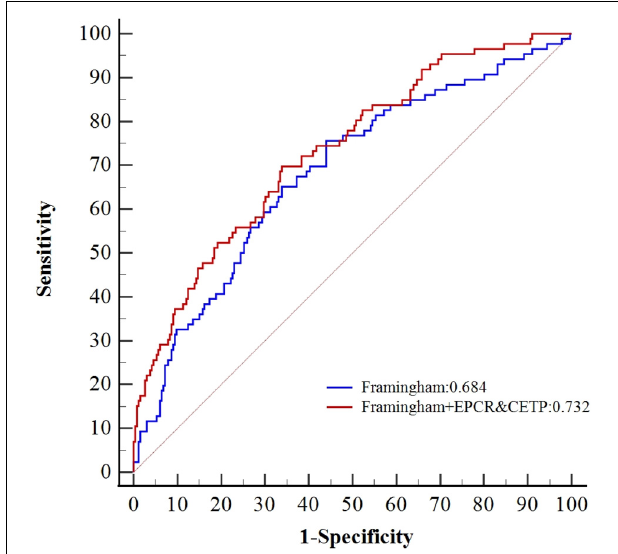
FIGURE 4 | Comparative ROC curves of Framingham CHD risk model combined with CETP and